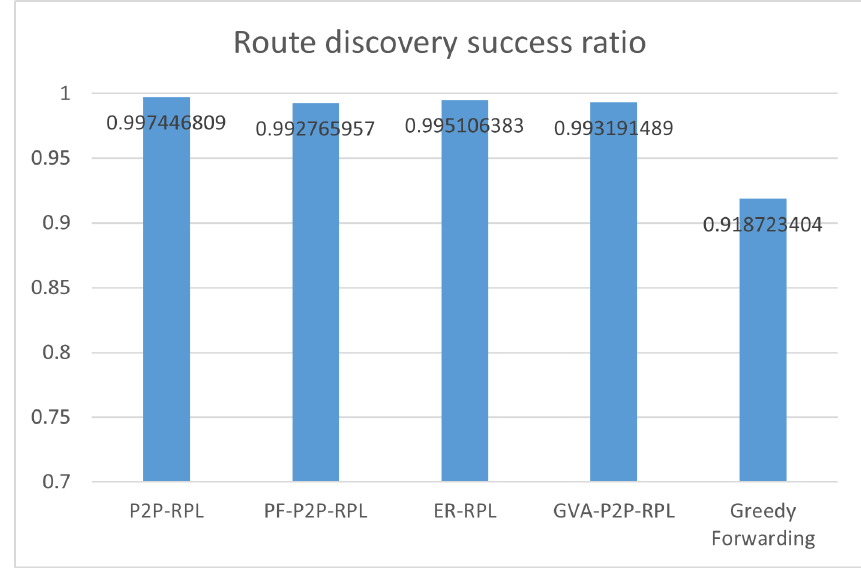
Figure 15. Route discovery success ratio.